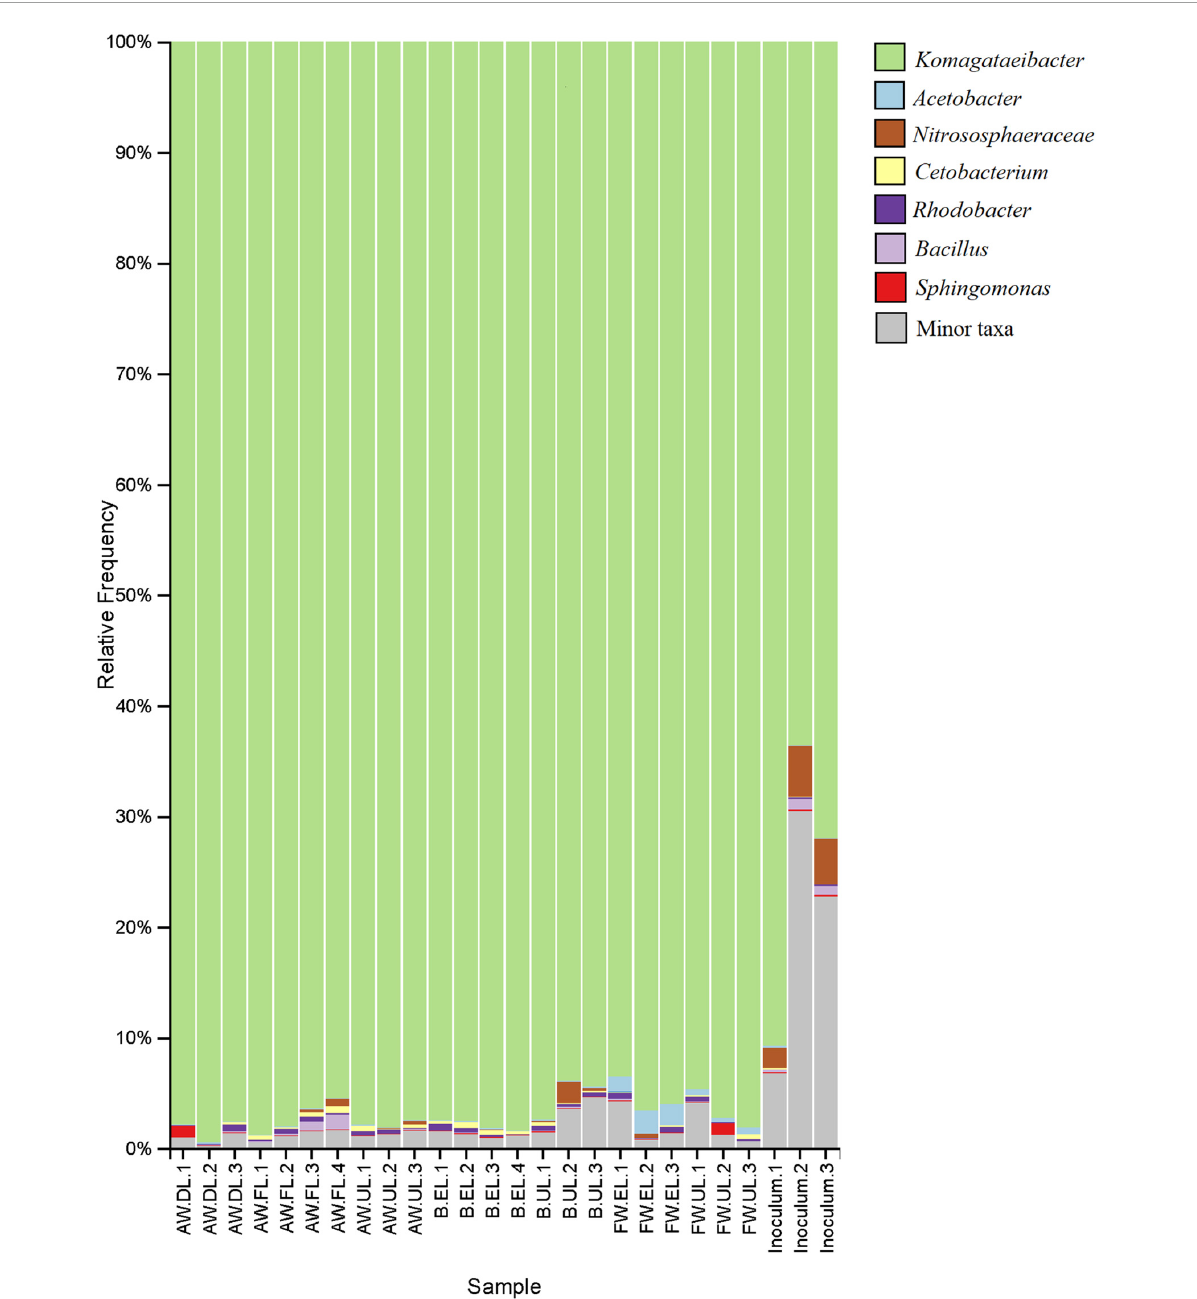
FIGURE7 Taxonomy bar plot showing the assignment of the total OTUs to the main taxa of the vinegar metagenome. The relative frequency (%) of OTUs provided by the taxa to each sample is represented up to the genus level as a maximum specificity. The list of taxa assigned to each one of the total OTUs, including the main taxa and those conforming to a minor fraction (see gray color) can be found in Supplementary Table 2 . AW, alcohol wine; B, beer; FW, fine wine; EL, end of loading phase (FL, fast loading; DL, discontinuous loading); UL, just before